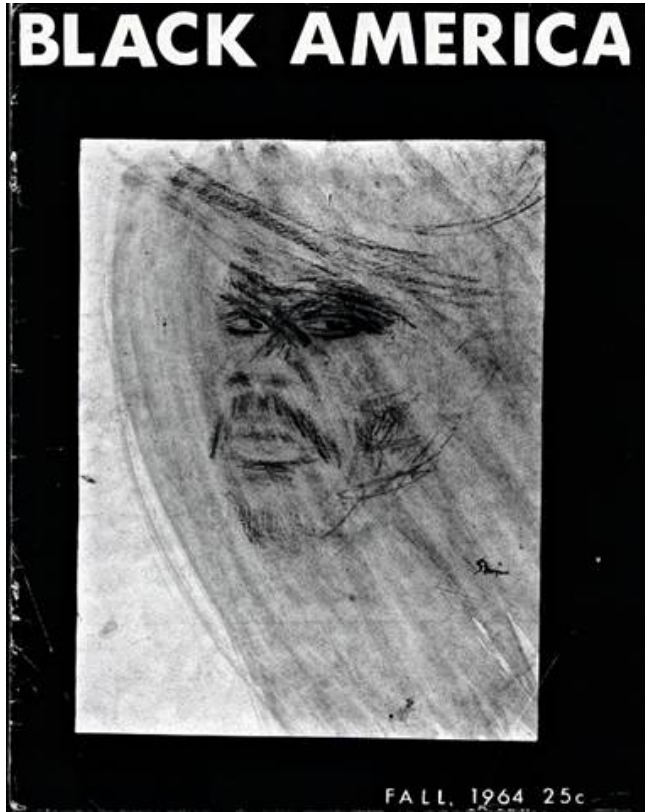
Figure 3 Cover of Black America , fall 1964. Max Stanford.